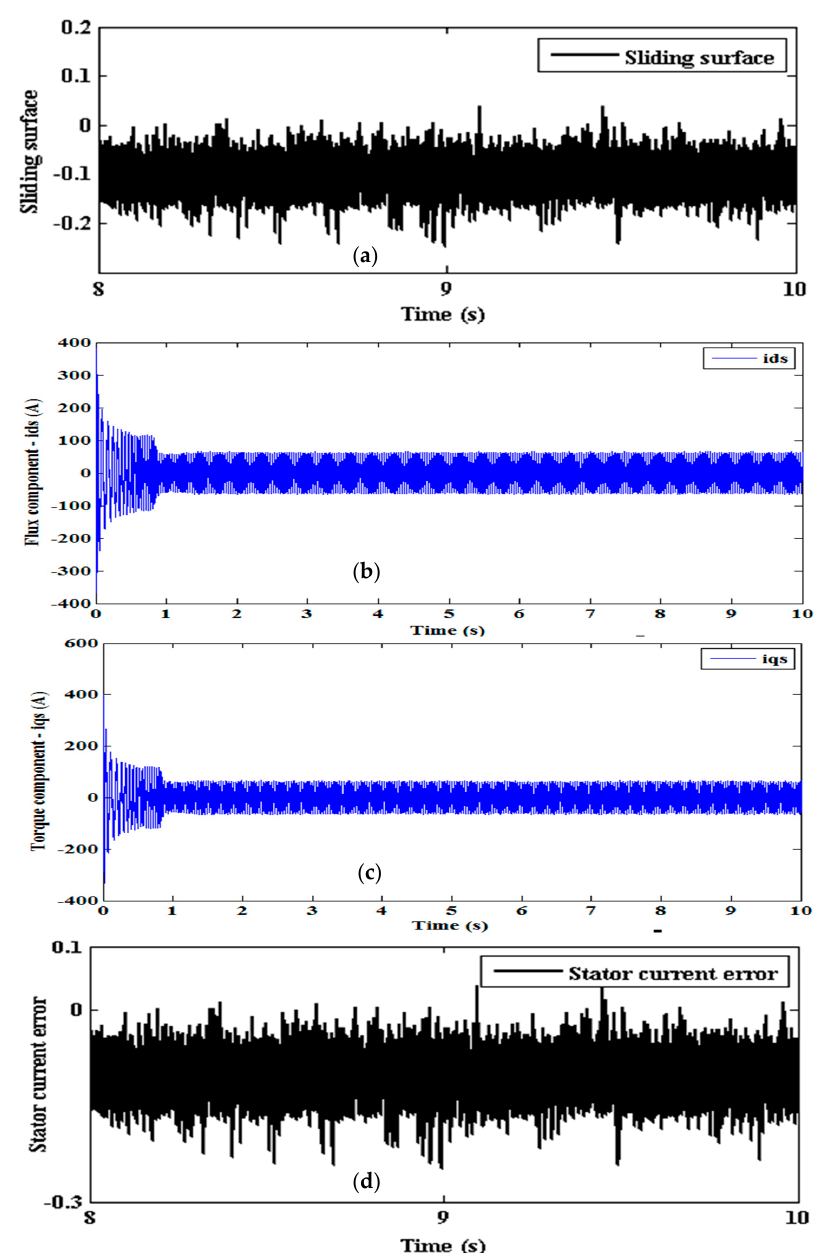
Figure 24. SMLO 2 ( a ) sliding surface; ( b ) flux component of stator current; ( c ) torque component of stator current; and ( d ) stator current error.